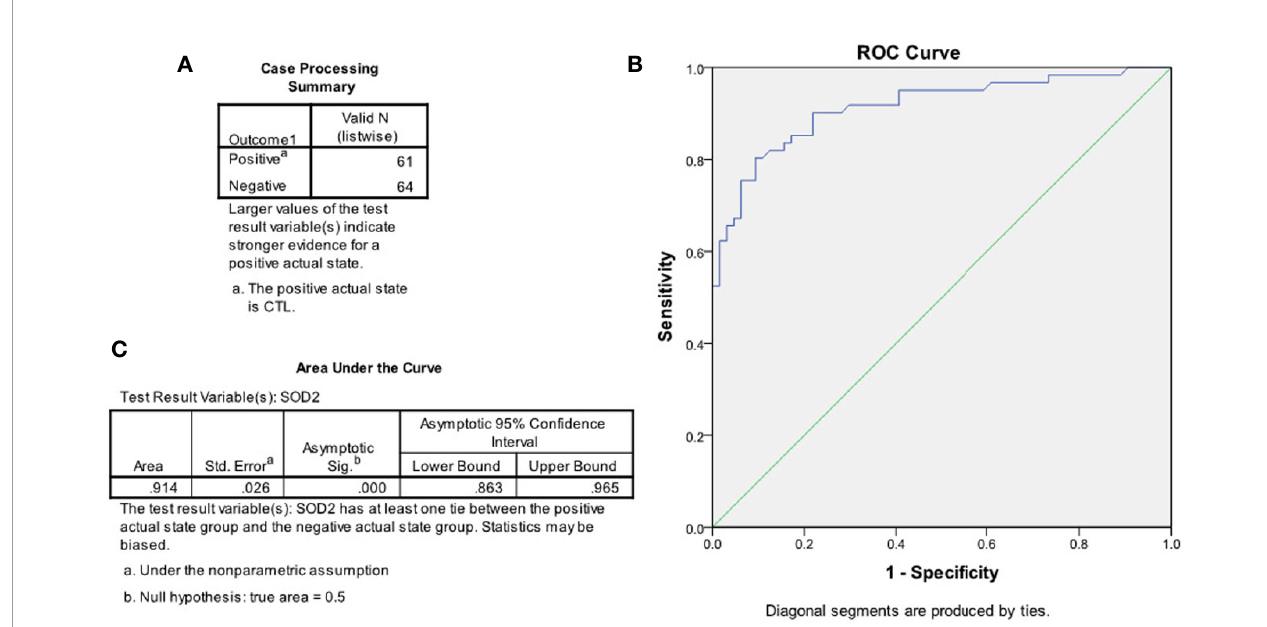
FIGURE 6 | The ROC curve based on SOD2 expression for ASD diagnosis. The SOD2 mRNA expression levels from both CTL (n = 61) and ASD (n = 64) patients were used to draw the ROC (receiver operating characteristic) curve. (A) Case processing summary, positive represents CTL cases, and negative represents ASD cases. (B) ROC curve. (C) Area under the